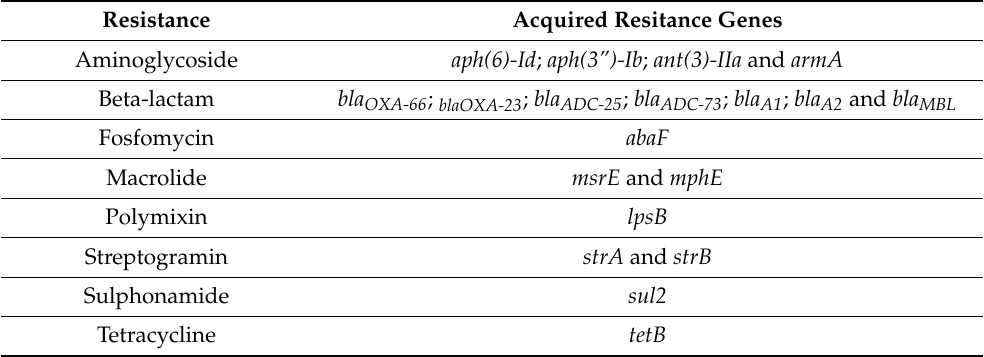
Table 3. Additional antimicrobial resistance-associated genes investigated using whole-genome